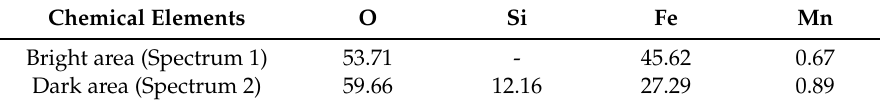
Table 1. Main atomic percentages of different layers (at. %).